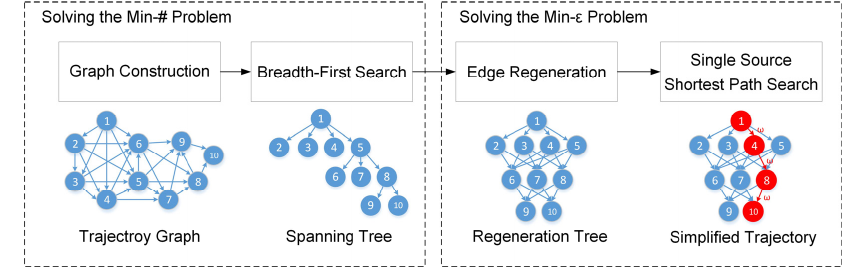
Figure 3. Flow chart of the OPTTS.